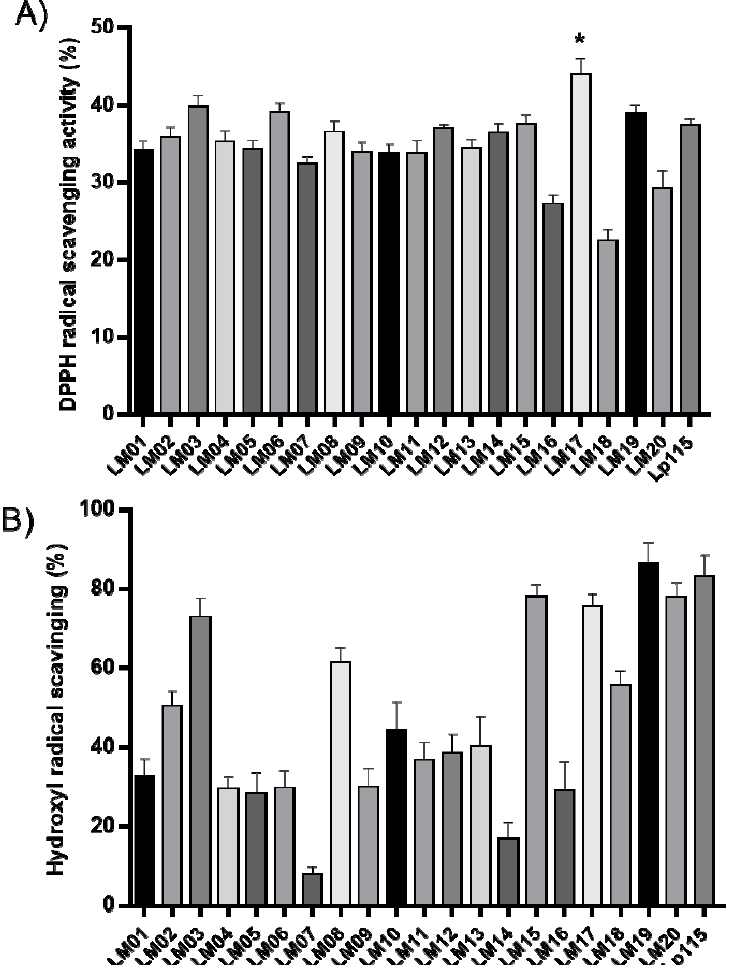
Figure 3. DPPH radical-scavenging ( A ) and hydroxyl radical-scavenging ( B ) activities of lactic acid bacteria (LAB) . Results are the mean from three independent experiments; error bars indicate the mean ± SEM. * indicates a significant difference as compared to L. plantarum Lp115 ( p < 0.05).